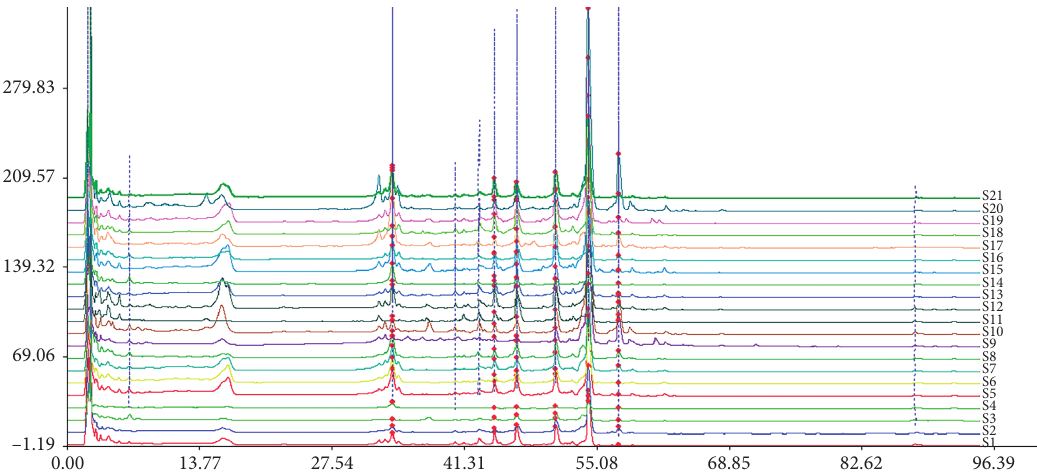
Figure 2: HPLC fingerprint of total saponins of Glycyrrhiza uralensis Fisch. from 21 producing areas.